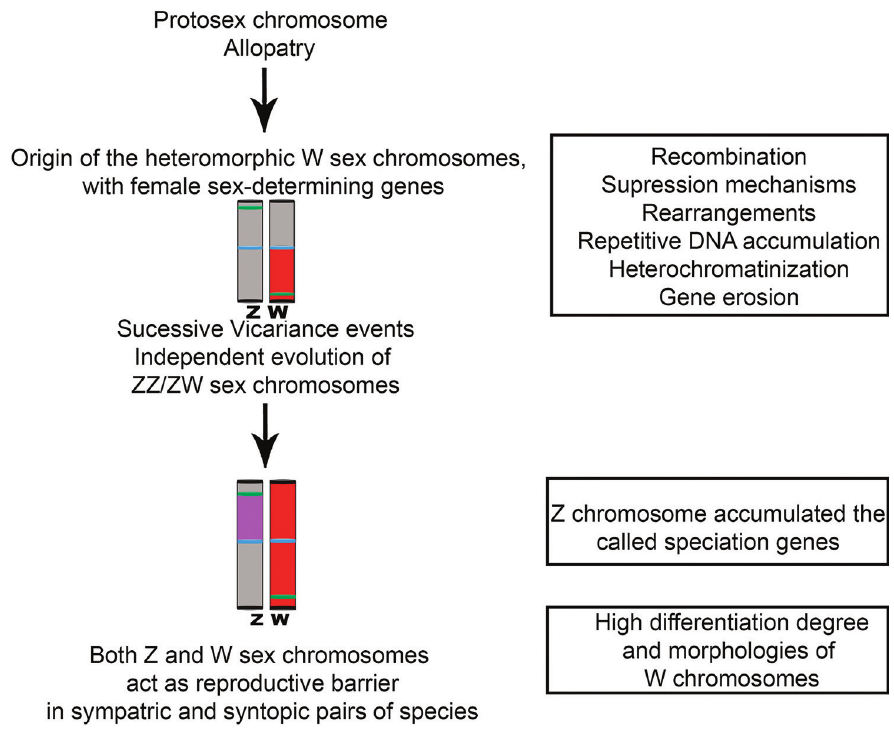
Figure 4. Schematic idiograms showing some steps proposed in the differentiation process of the ZZ/ ZW sex pair. The origin of the ZZ/ZW sex pair from the protosex chromosome of the Characidium spe- cies. Centromeric region (blue); 18S rDNA site (green); W specific probe region (red); probable Z specia- tion genes region